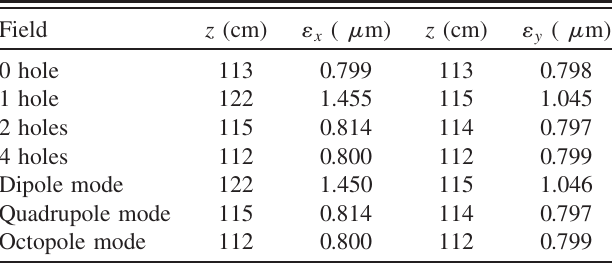
TABLE V. Minimum emittance for 1 nC charge.